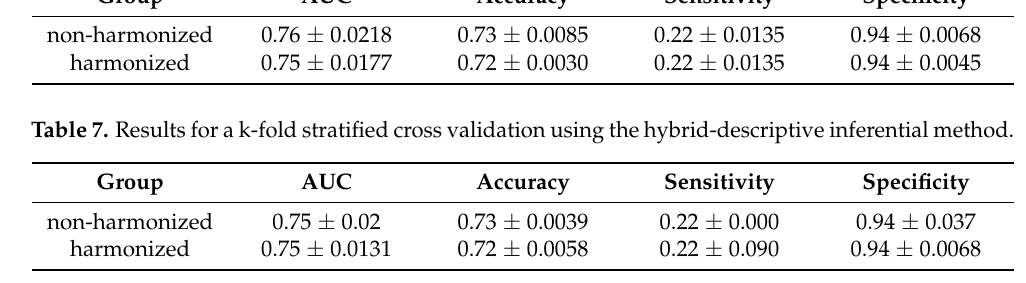
Table 5. Results of the feature selection step using the LASSO algorithm. Selection Group Algorithm